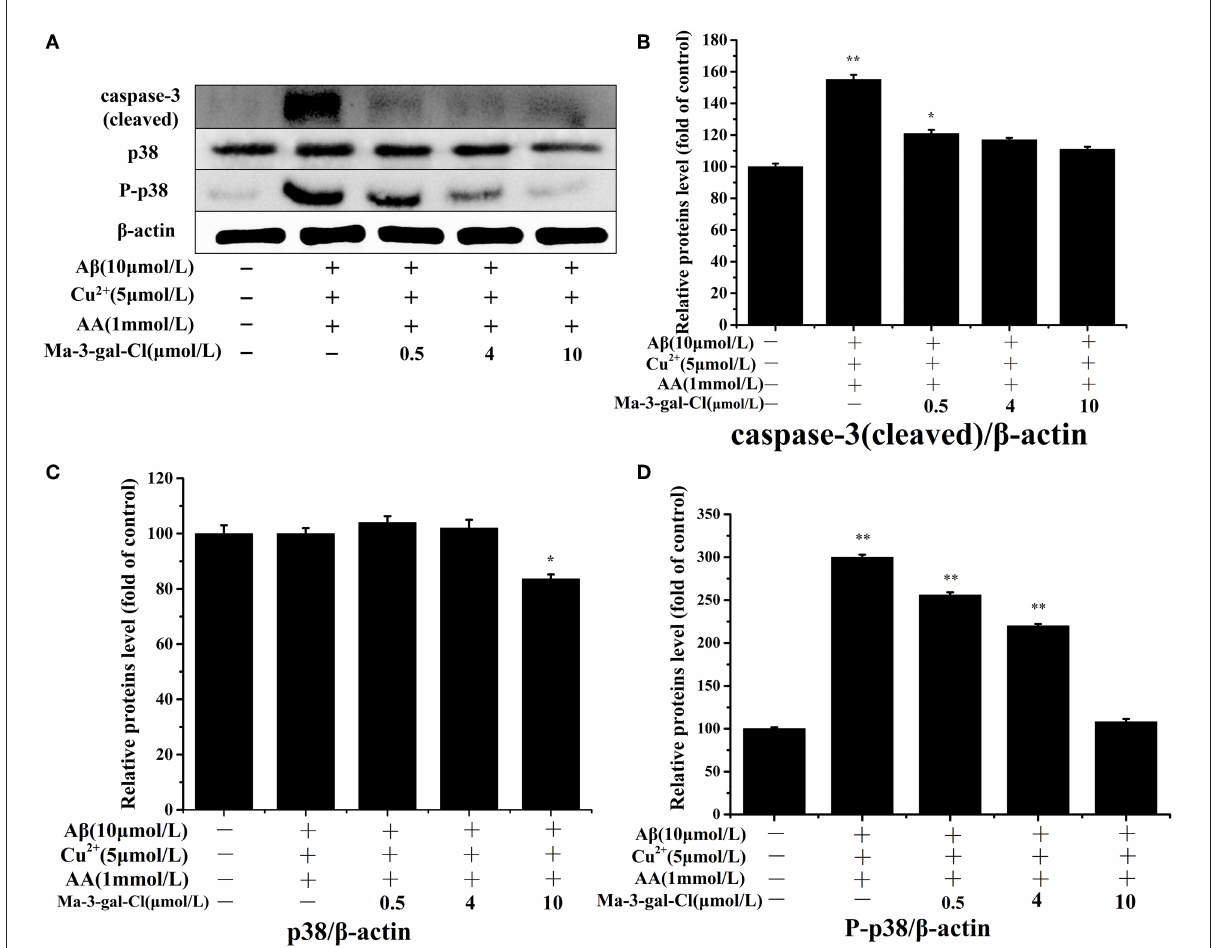
FIGURE5 Western blot results (A) and effect of Ma-3-gal-Cl on the expression of caspase-3 (cleaved) (B) , p38 (C) , and P-p38 (D) in pretreated SH-SY5Y cells. * P < 0.05 and ** p < 0.01 compared to control